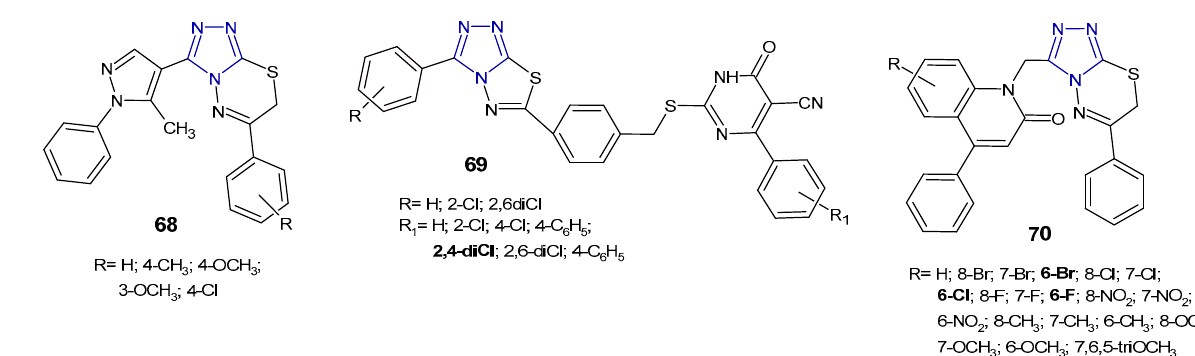
19 of 30 Figure 20. Antibacterial derivatives of 1,2,4-triazolo[3,4- b ][1,3,4]thiadiazoles and 1,2,4-triazolo[3,4- b ][1,3,4]thiadiazines— continued. Several simple or aryl hydrazone pyrazole-containing derivatives of 1,2,4- triazolo[3,4- b ][1,3,4]thiadiazin-6-yl-2 H -pyran-2-one were obtained by Penta et al. (2013) via one-pot, multicomponent reaction. The results of antibacterial activity against Gram- positive ( S. aureus and B. subtilis ) and Gram-negative bacteria ( E. coli and K. pneumoniae ) showed that some aryl hydrazone derivatives inhibited the growth of all bacterial strains. Among them, compound containing a 3-nitro group on the phenyl ring 65 (Figure 20) showed a maximum zone of inhibition (24.0–35.0 mm), even greater than that of the standard drug, kanamycin (zone of inhibition 23.0–32.0 mm). In the MIC tests, this compound was identified as the most potent inhibitor with significant MIC values ranging from 6.0 to 10.0 µg/mL, which was more or equally potent as kanamycin (MICs: 4.0–11.0 µg/mL) [76]. In 2013, Behalo et al. synthesized a series of fused 1,2,4-triazole derivatives 66 – 67 (Figure 20), starting with 4-amino-5-[(quinolin-8-yloxy)methyl]-4 H -1,2,4-triazole-3-thiole to determine in vitro antibacterial activity against S. aureus and E.coli . The tested compounds showed a moderate 66a – b (inhibition zone of 13–15 mm) to high effect 67b (inhibition zone of 20–21 mm) against the tested bacteria, in comparison with tetracycline. It is interesting, that 3-((quinolin-8-yloxy)methyl)-1,2,4triazolo[3,4- b ][1,3,4]thiadiazol- 6(5 H )-thione 67b inhibited bacterial growth to a greater extent than its 6-oxo analogue 67a , which showed no antibacterial effect [77]. Reddy et al. (2015) synthesized 1,2,4-triazolo[3,4- b ][1,3,4]thiadiazines 68 (Figure 21) containing 5-methyl-1-phenyl-1 H -4-pyrazolyl moiety at the 3-position of triazole, and